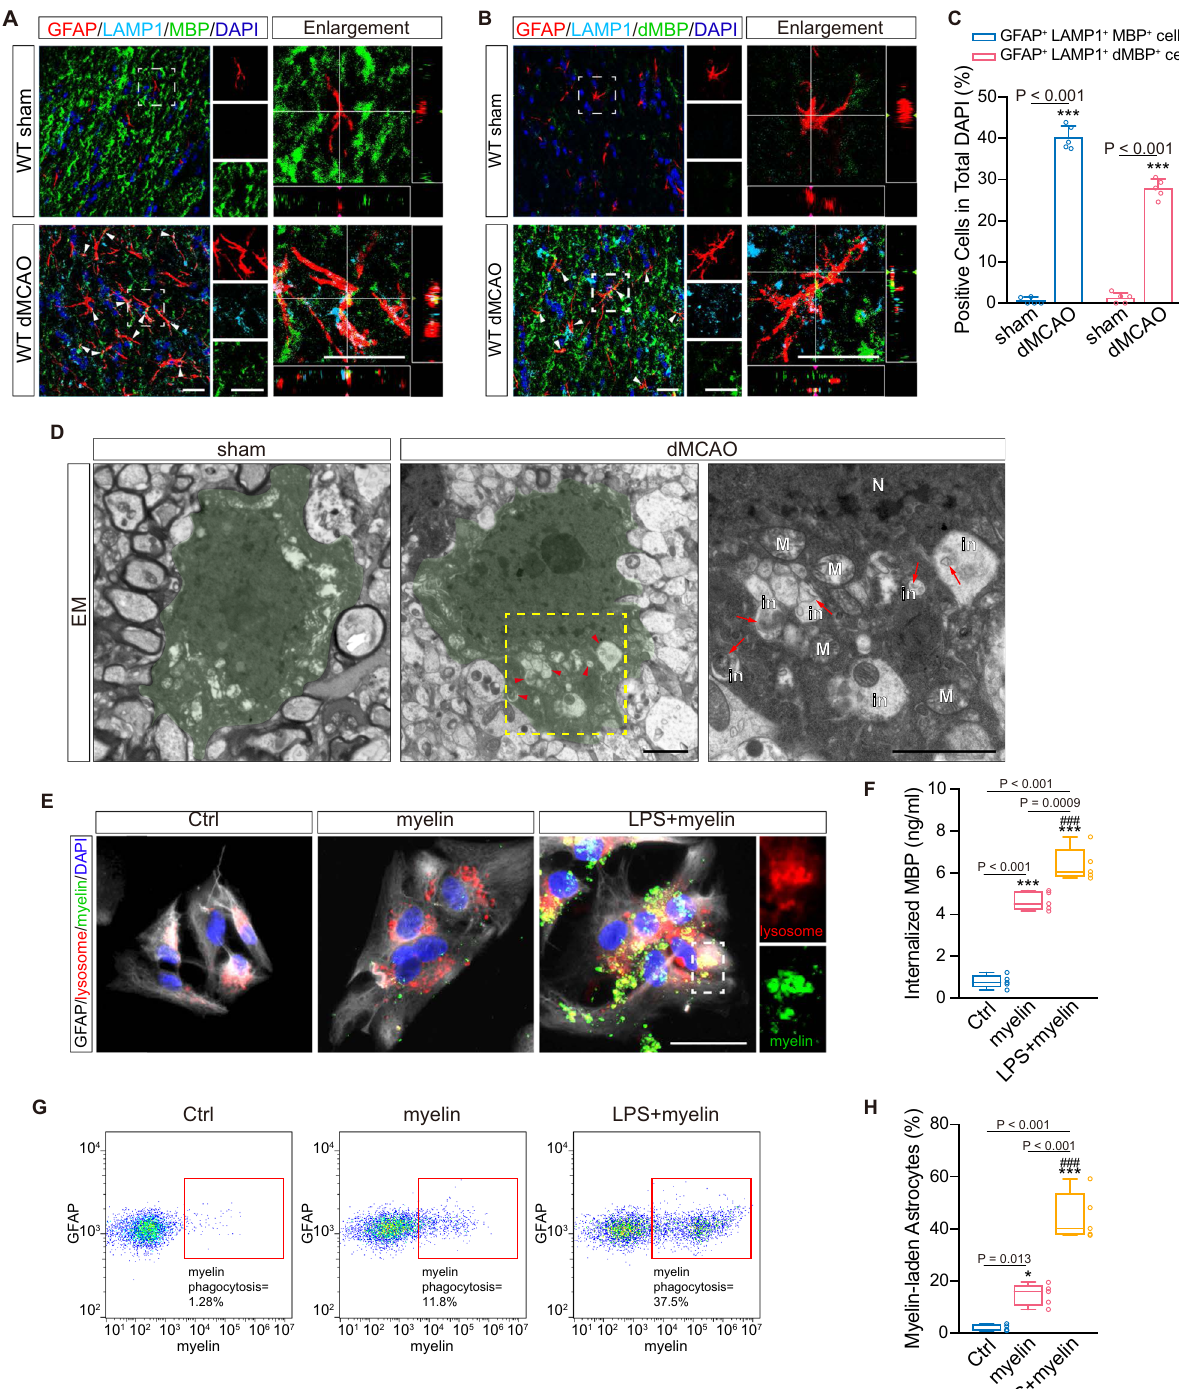
compared to WT dMCAO, P < 0.001), higher percentages of myelinated axons (Fig. 6F, H; compared to WT dMCAO with adjusted P of 0.0083, P = 0.0011) and lower g-ratios (Supple- mentary Fig. 6E, F; compared to WT dMCAO group, P = 0.021) than WT dMCAO mice. function from 1 to 28 days post operation, while Lcn2 de fi ciency partially reversed neurological de fi cits, with remission of the score on the 7th day after insult (Fig. 6I; compared to WT